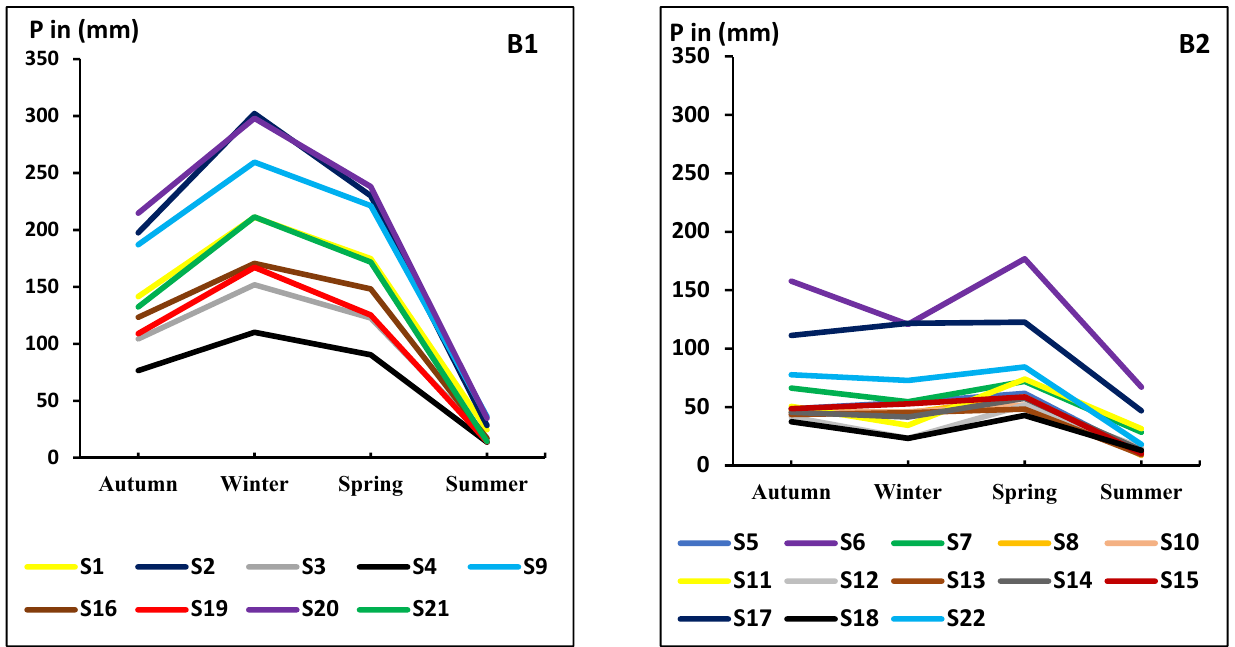
Figure 6. Seasonal rainfall regime of the two clusters ( B1 , B2 ) after homogenization. Method performance and data quality are assessed using the root mean square error (RMSE) values. The RMSE is calculated by comparing the estimated and observed data in each series. High values of this parameter indicate poor quality of the series, or that the station is located in a particular site with a distinct microclimate [19].